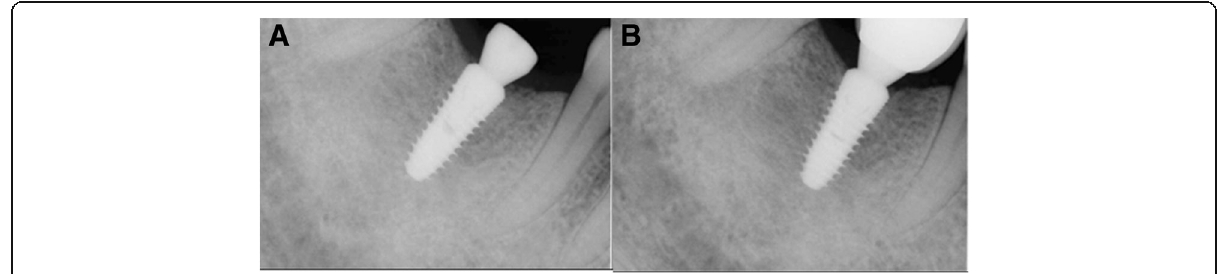
Fig. 4 M3, periapical radiograph, a #46i, second operation, b #46i, prosthesis delivery